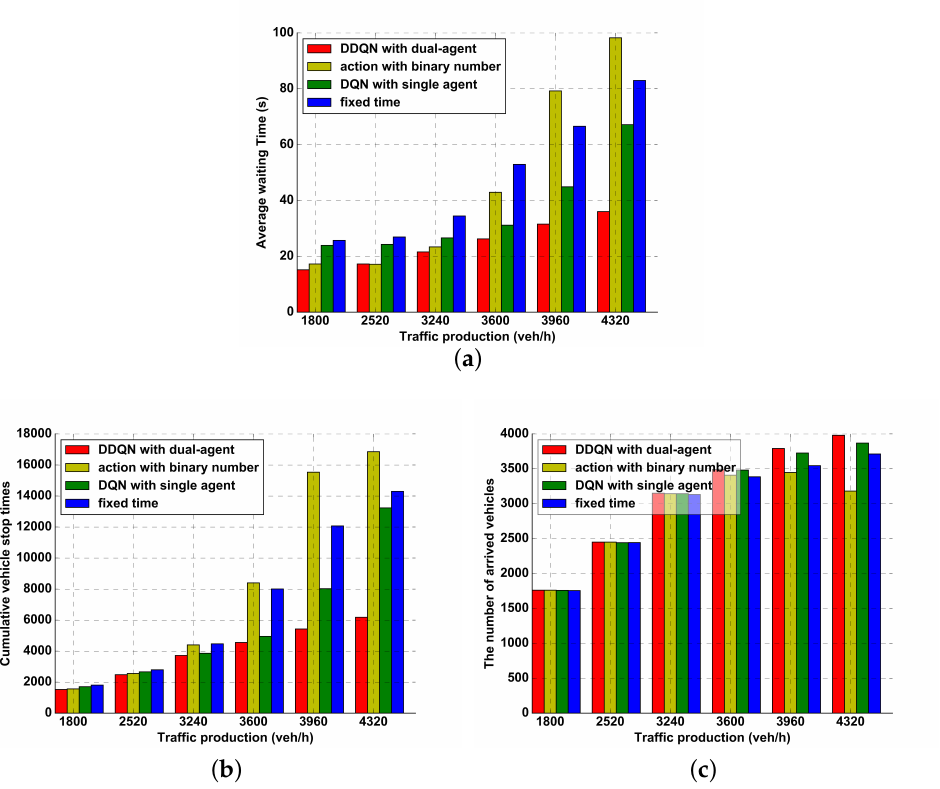
Figure 9. Comparison performances of different traffic signal control algorithms: ( a ) average waiting time; ( b ) the number of stops; ( c ) the number of arrived